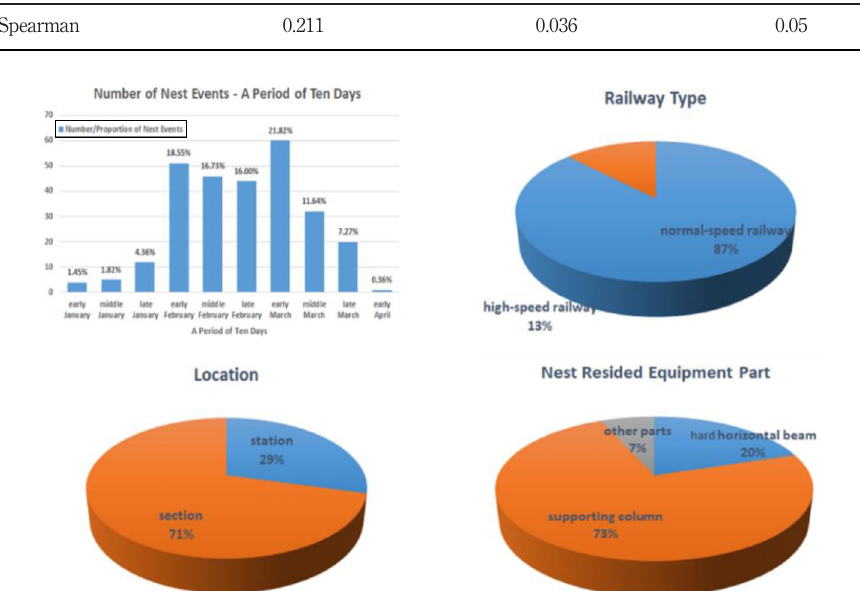
between the nest event frequency and